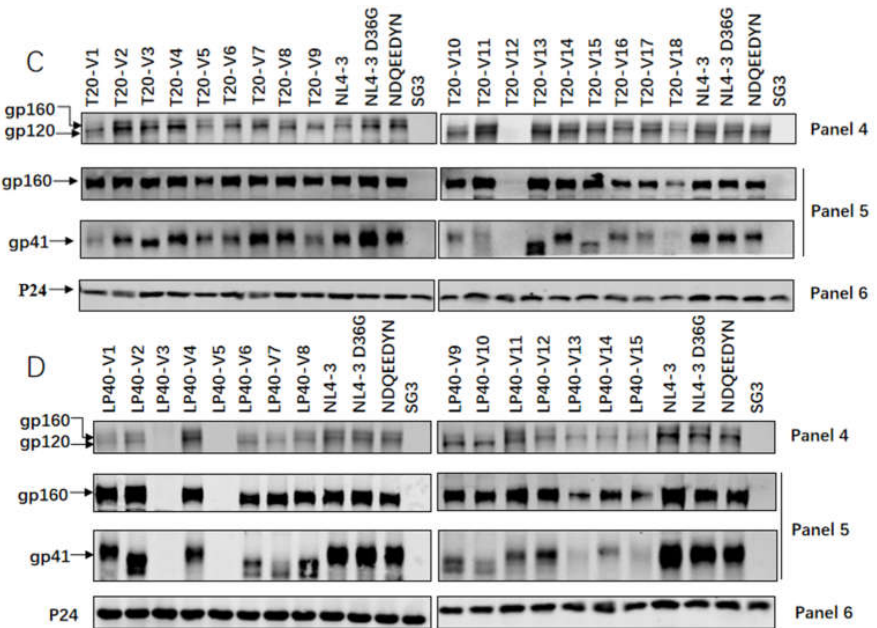
Figure 5. Expression and processing profiles of HIV-1 NL4-3 Env, detected using Western blotting. The ( A ) T20- and ( B ) LP40-resistant mutant glycoproteins in the lysates of transfected cells were detected with a rabbit anti-gp120 polyclonal antibody (panel 1) and 10E8 (panel 2). The β-actin protein was detected as an internal control (panel 3). Env incorporation in ( C ) T20- and ( D ) LP40-resistant pseudoviruses was determined using immunoblotting. Concentrated virions were re-suspended in RIPA lysis buffer, then normalized to a fixed amount using P24 antigen and subjected to SDS-PAGE. A rabbit anti-gp120 polyclonal antibody (panel 4) and 10E8 (panel 5) were used to probe gp160, gp120, and gp41. As an internal control, the P24 antigen was detected with a rabbit anti-HIV P24 polyclonal antibody (panel 6). The experiments were repeated three times, and representative data are shown.